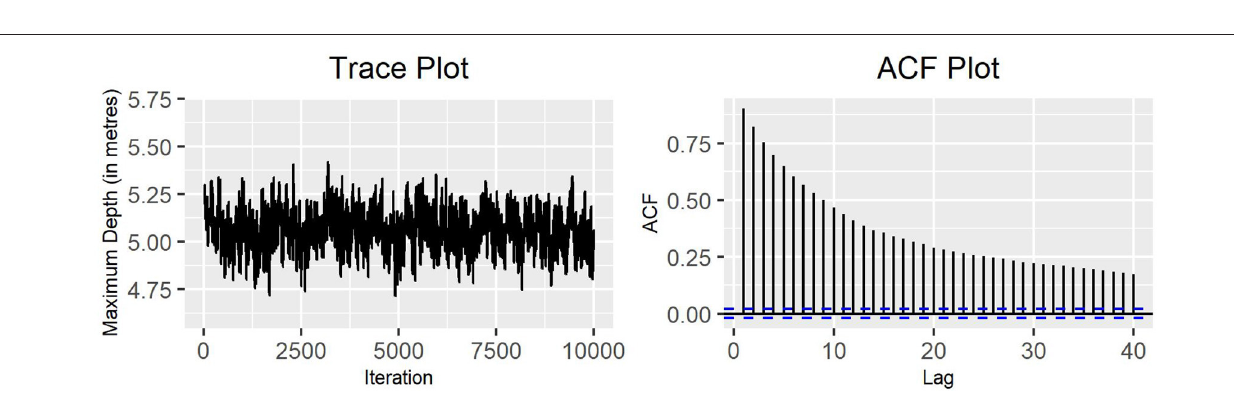
2. Production state 2 captures moderately long (7.6–77.5